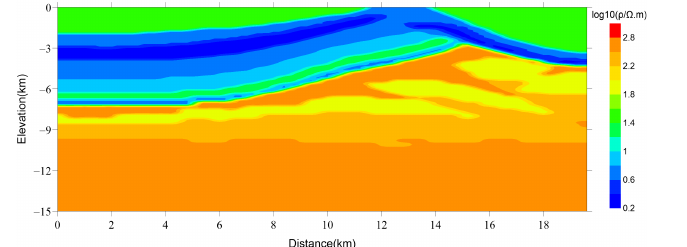
Figure 1. 2D resistivity model.